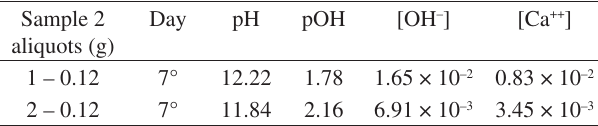
Table 4. pH of the aliquots of samples 1 and 2 after seven days.